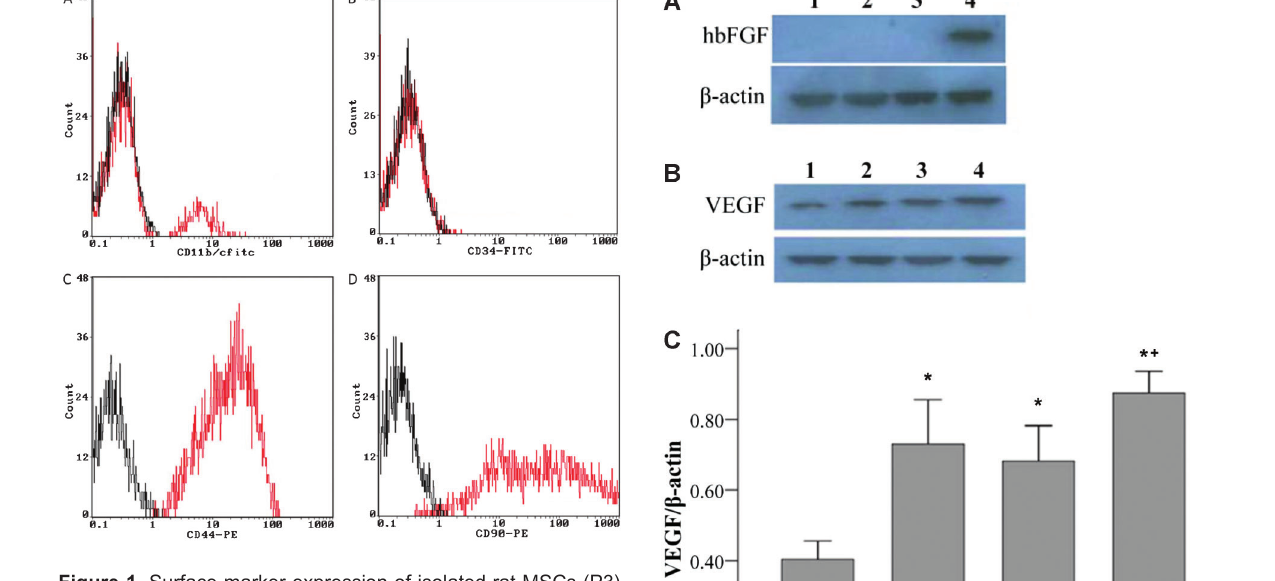
Figure 1. Surface marker expression of isolated rat MSCs (P3). The expression of CD11b/c ( A ), CD34 ( B ), CD44 ( C ), and CD90 ( D ) was determined using flow cytometry (red lines). Their respective negative controls were also included (black lines).